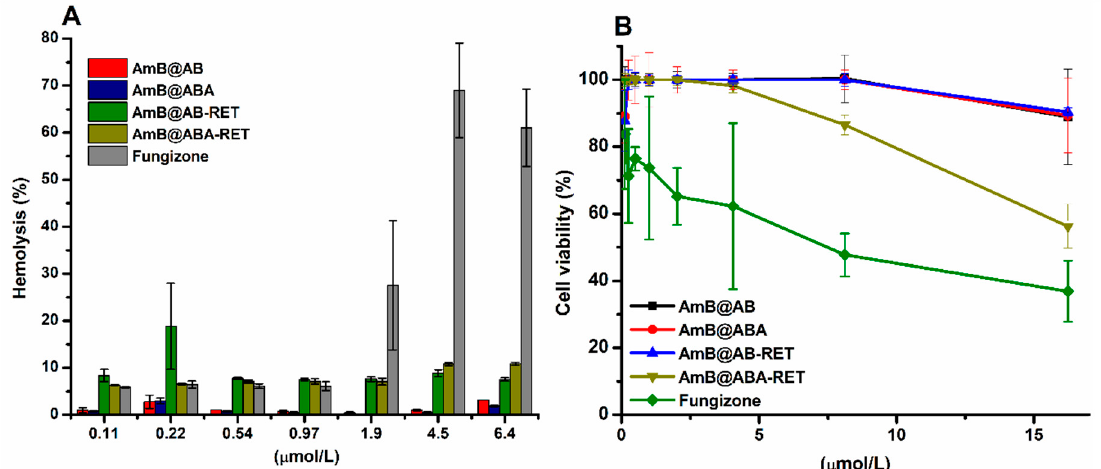
Figure 7. ( A ) Haemolytic profiles of AmB@PMs and Fungizone ® and ( B ) Cell viability of mouse fibroblasts (L929) in the presence of AmB formulations.